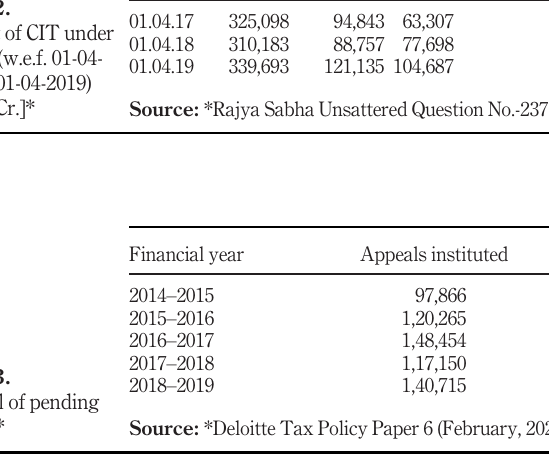
Table 3. Disposal of pending